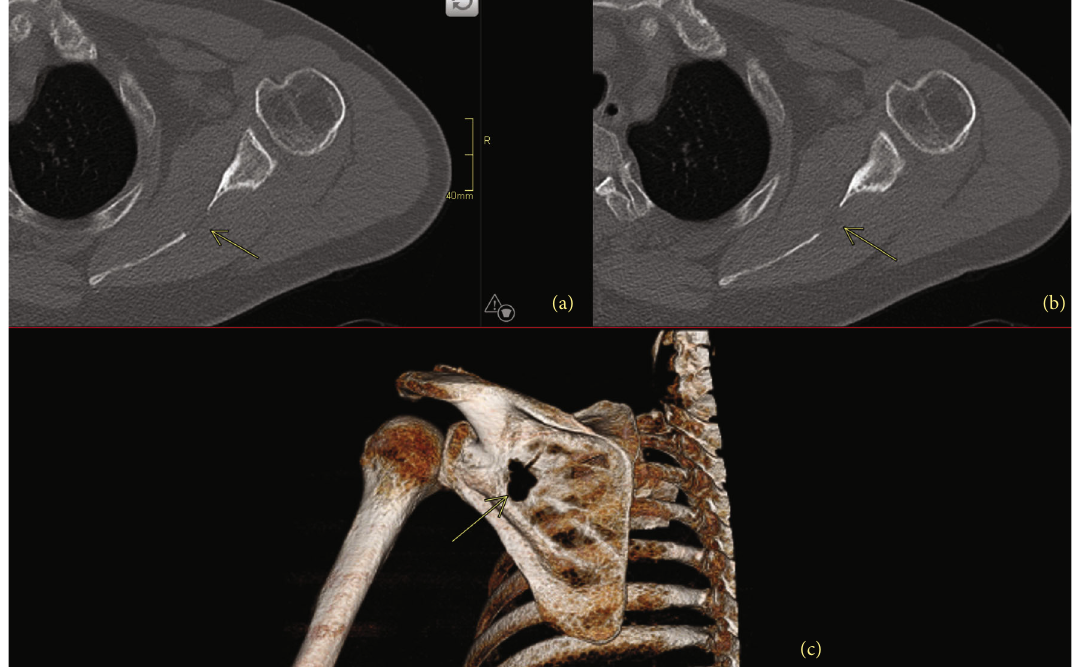
Figure 2: Case 1: left scapula CT and reconstruction images. Axial (a and b) and 3D reconstruction (c) CT images demonstrating the primary bone PMT arising from the left scapular body (arrow) in the patient from Case 1, corresponding to the fi ndings from the DOTATATE-PET/CT in Figure